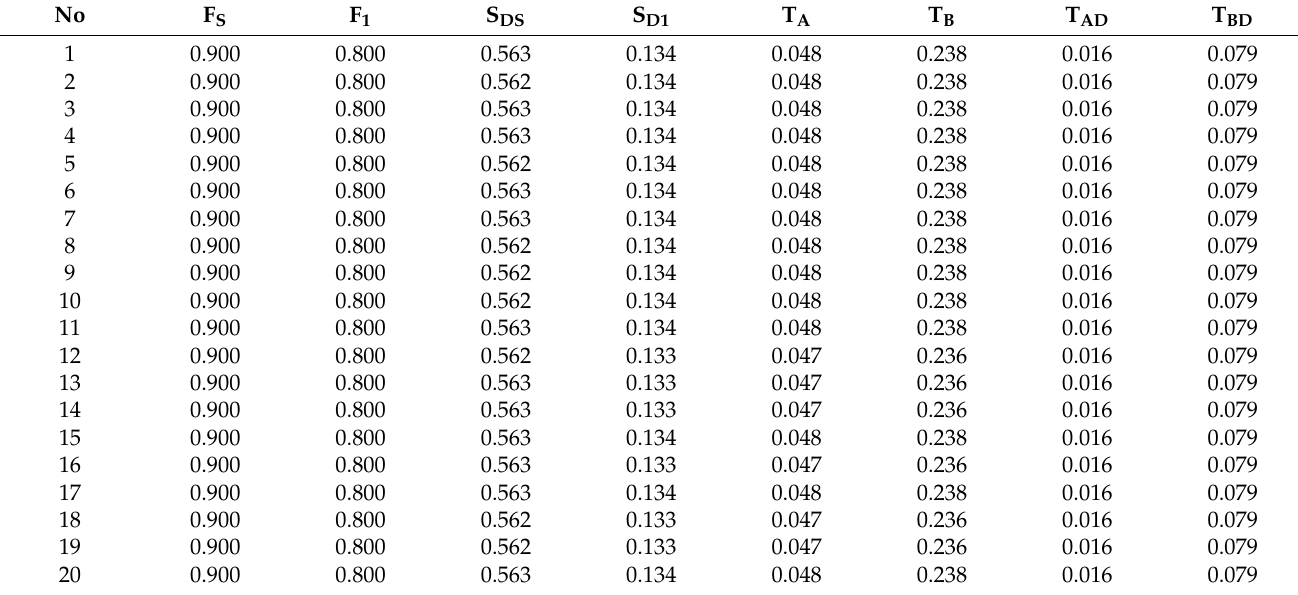
Table 5. Seismic parameters for selected